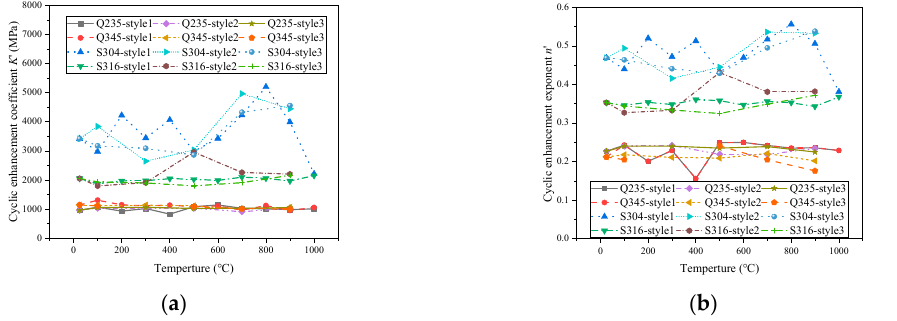
Figure 20. Parameters for Ramberg–Osgood relation. ( a ) Cyclic enhancement coefficient ( K ’); ( b ) Cyclic enhancement exponent ( n ’).